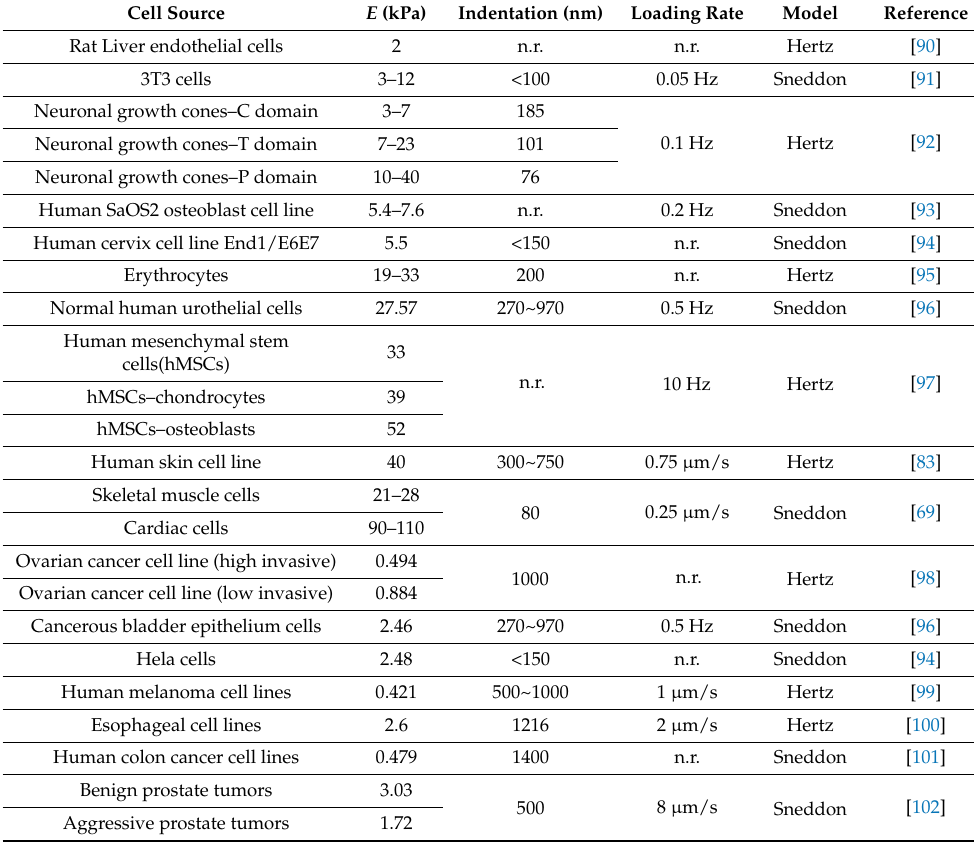
Table 1. Young’ modulus of mammalian cells using